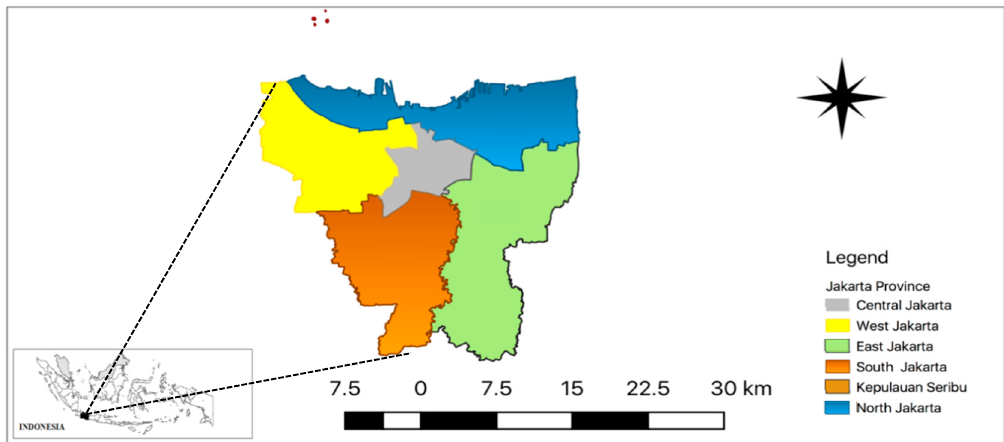
Figure 1. Map of Indonesia showing the location of Jakarta Province and its municipalities and district administration. Source: Indonesian Geospatial Information Agency [40].